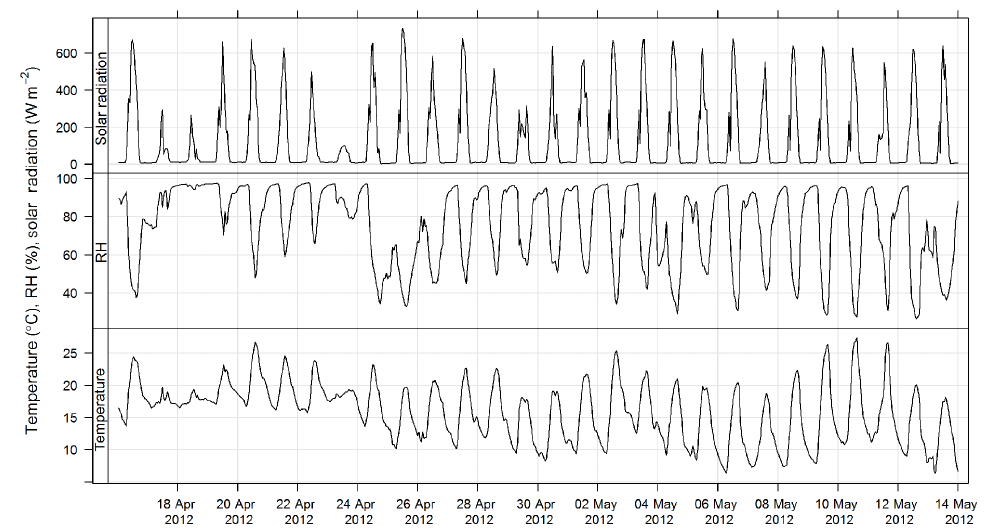
Figure 10. Time series of ambient temperature, relative humidity, and solar radiation during